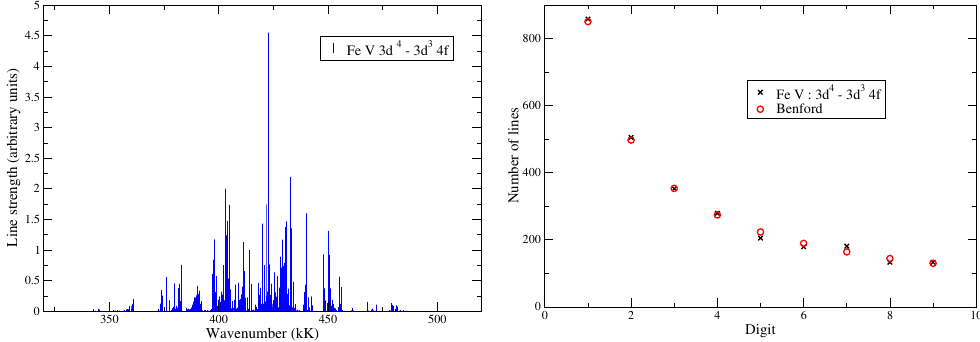
3 d 3 4 f (line strength as a function of energy) computed with Cowan’s Figure 9. Transition array 3 d 4 − code [56] and number of lines as a function of the first significant digit in the value of the strength.